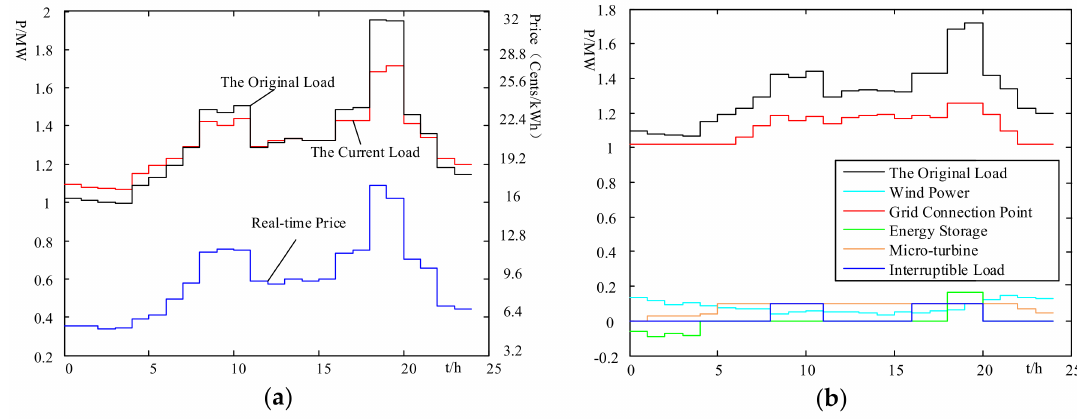
Figure 10. Results of day-ahead optimal dispatch with Strategy 3: ( a ) Power curves of each device; ( b ) state of the